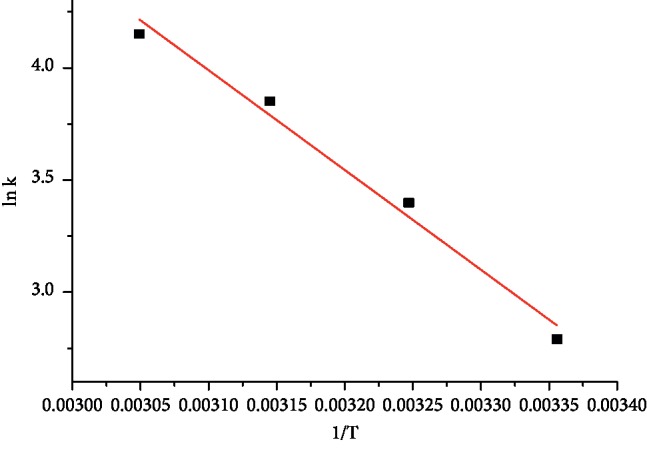
Plot of ln Kc versus T.